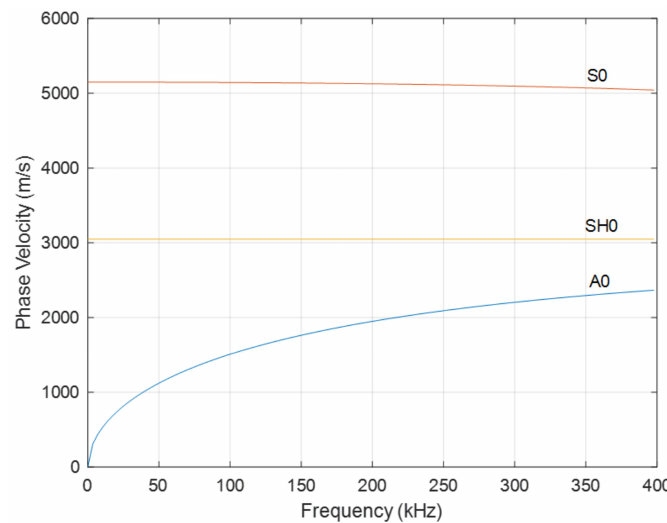
Figure 13. Predicted GW dispersion curves for a 3 mm thick stainless-steel plate.